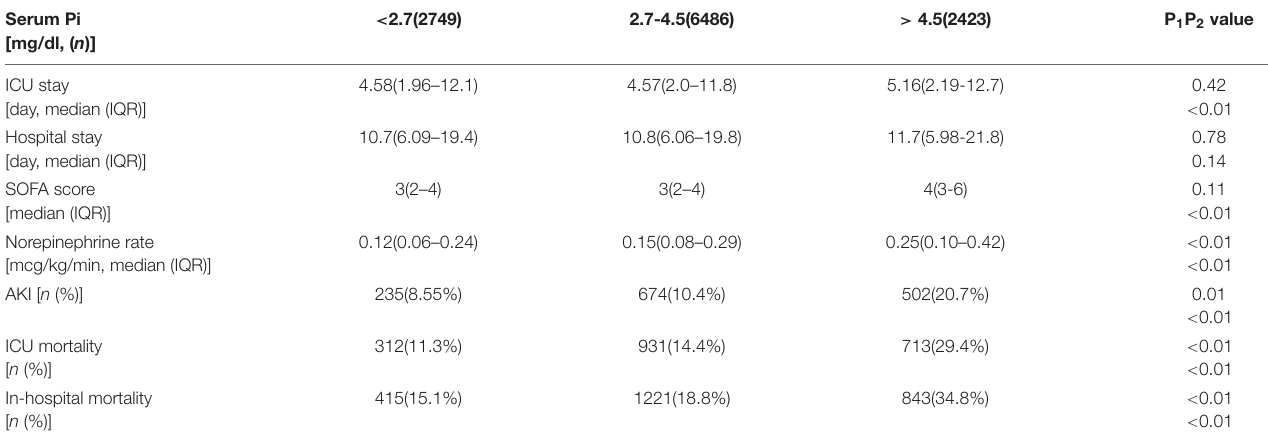
TABLE 2 | Unadjusted relationships between serum inorganic phosphate (Pi) groups and crude outcomes. Serum Pi [mg/dl, ( n )]